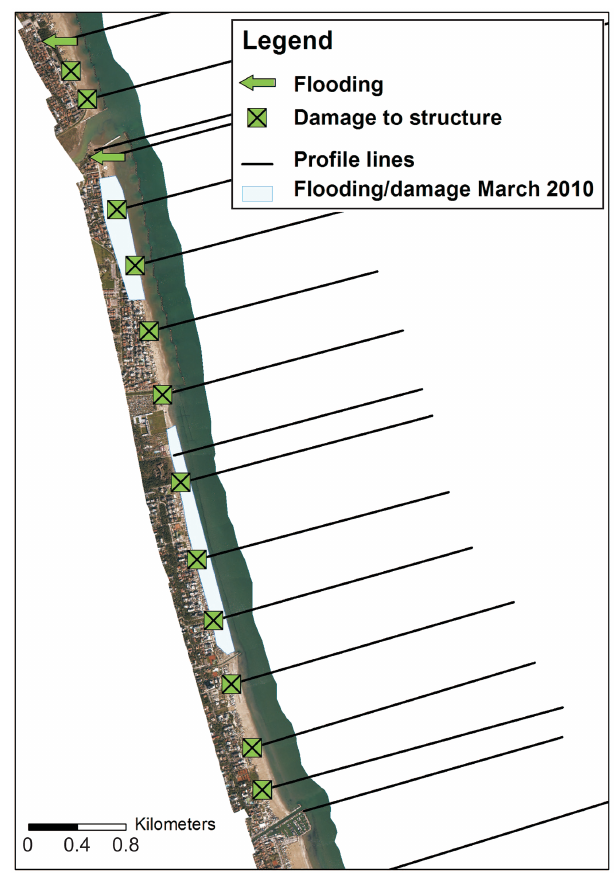
Figure 4. Location of impacts after the March 2010 storm along the Lido di Savio area and vulnerability symbology along profile lines of the 10-year return period